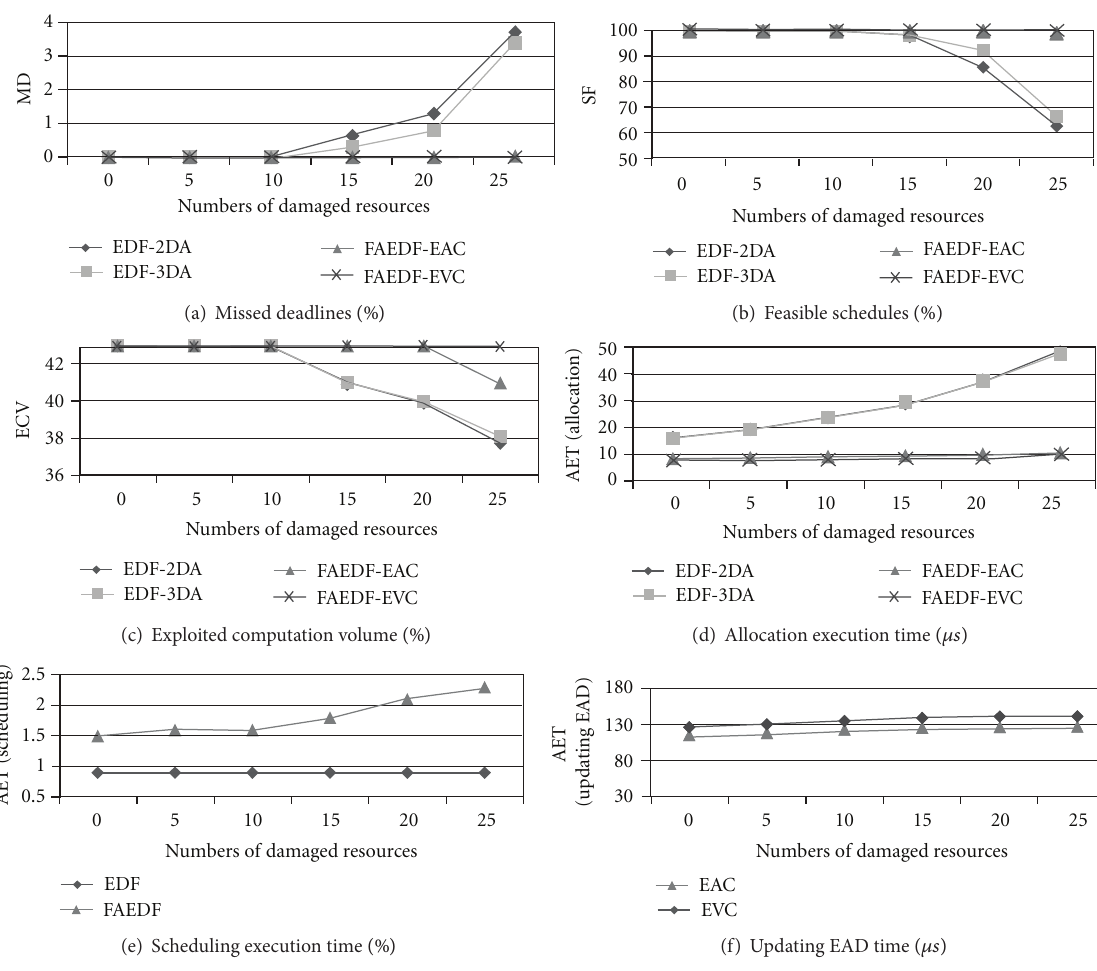
= 0.5 and 𝑈 = 0.5 ICAP COMP